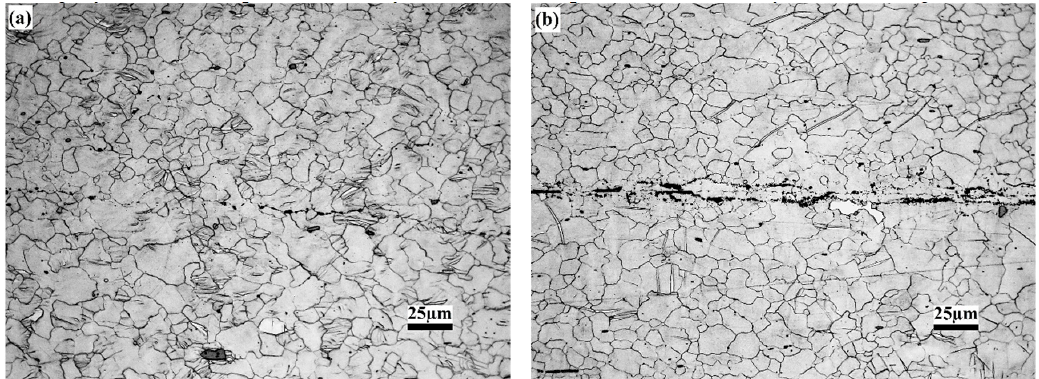
Figure 9. Light microscopy microstructure of interface flat region: ( a ) joint type A (1400 J); ( b ) joint type B (1100 J).